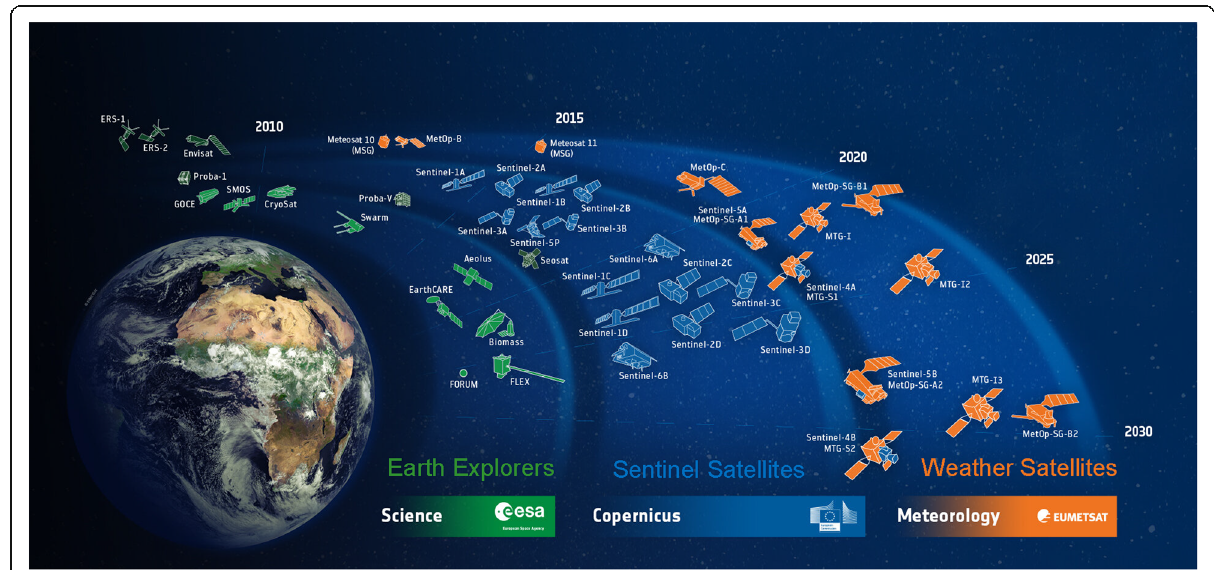
Fig. 7 The European Space Agency ’ s program in Earth observation from 2010 to 2030. The period from 2020 to 2025 is especially active, launching several science demonstration missions (green, the Earth Explorers), a large number of Copernicus satellites, the Sentinel operational mission series of Earth observers, and the Operational Meteorology program operated by EUMETSAT, with several Sentinel missions in partnership with